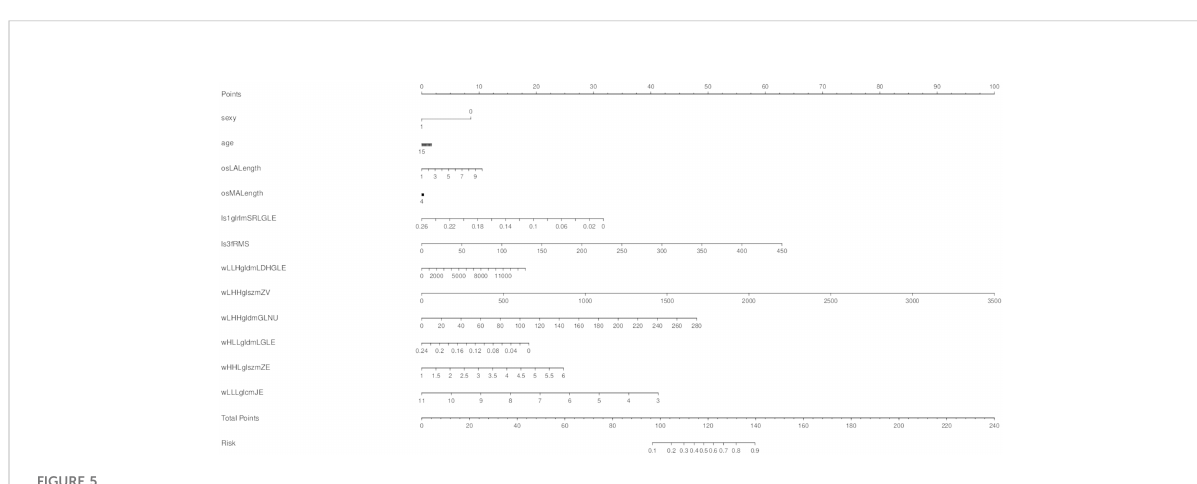
FIGURE 5 A nomogram was made to predict the one-year growth of single pulmonary nodules.